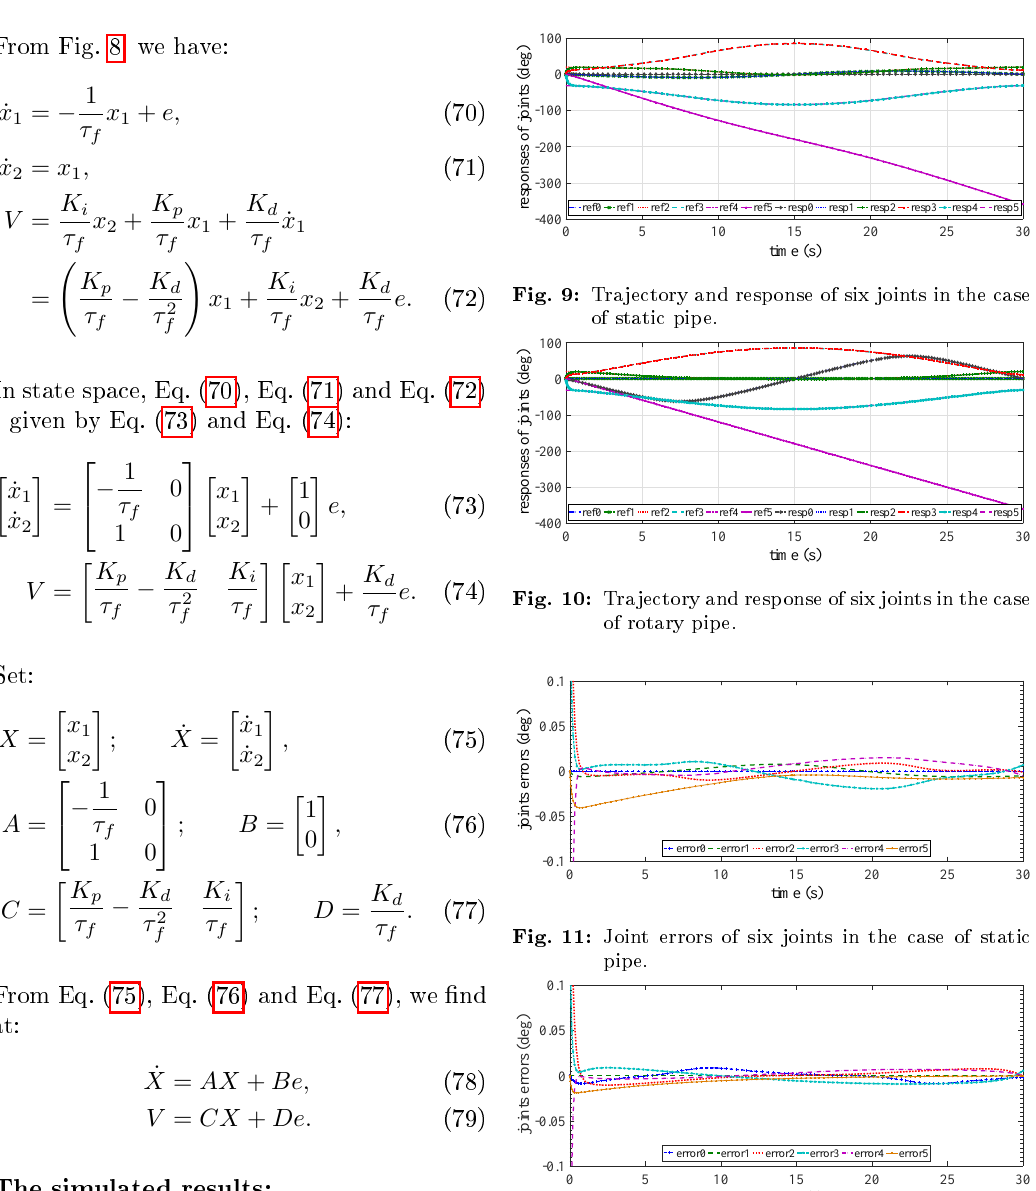
The maximum error belongs to joint 3 with a value of 0 . 009 ◦ . The best activity is joint 4 with a maximum error of 0 . 0006 ◦ . Figure 13 and Fig. 14 are the error graphs of the end-e(cid:27)ector in the three axes of X − Y − Z in the Cartesian space corresponding to two cases: standing and rotating. In Fig. 13: Position